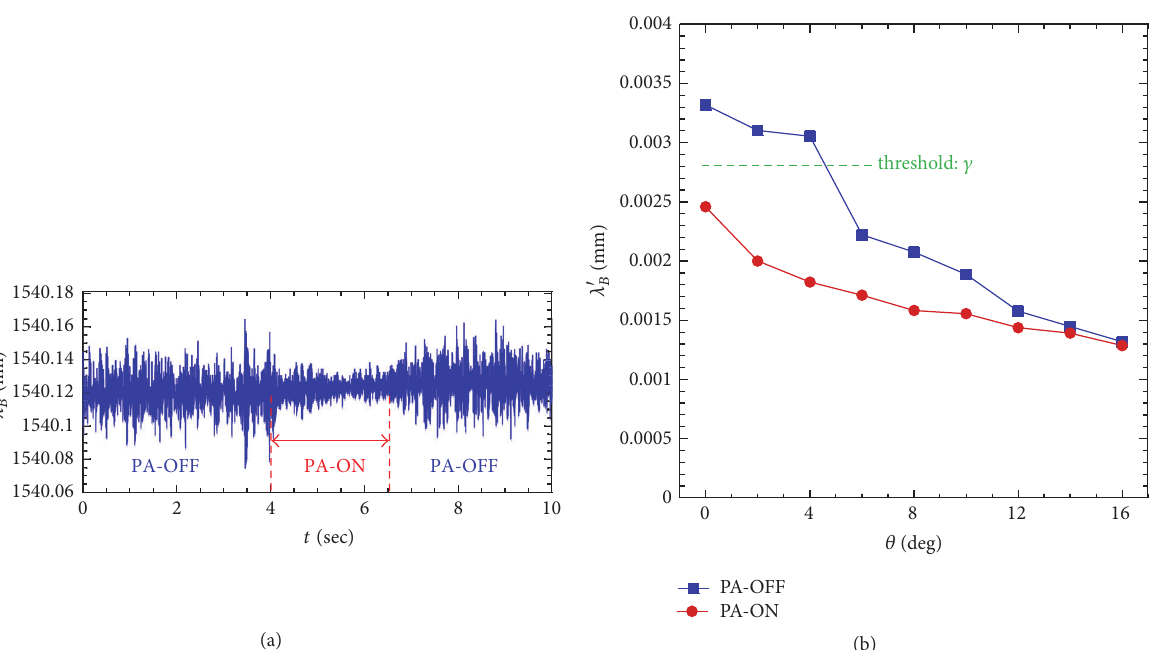
Figure 10: (a) 𝜆 𝐵 fluctuations under PA-OFF and PA-ON which are detected by FBG sensor attached to interior surface of cantilever (Figure 8(c)). (b) Standard deviations of Bragg wavelength ( 𝜆 󸀠 𝐵 ) as a function of 𝜃 .